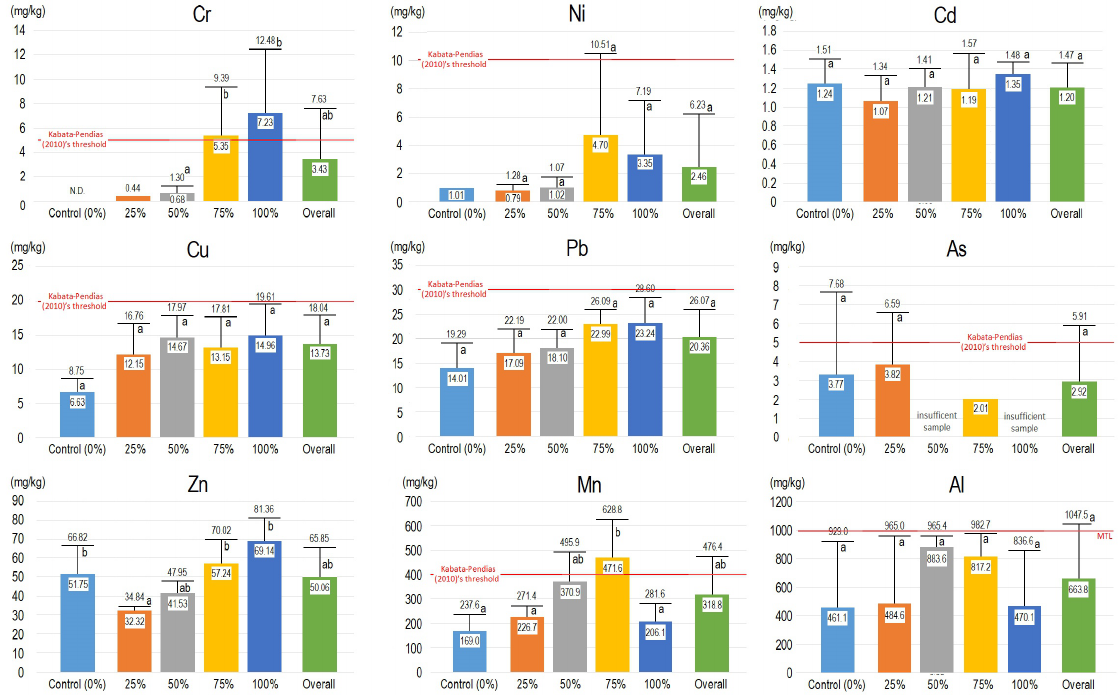
Figure 1. Metal levels of the above-ground biomass of bermudagrass under different sludge loading rates in DG. (Note: N.D. = not determined due to insufficient amount of sample for analysis. Error bars indicate the 95% confidence interval. Different letters denote the statistical